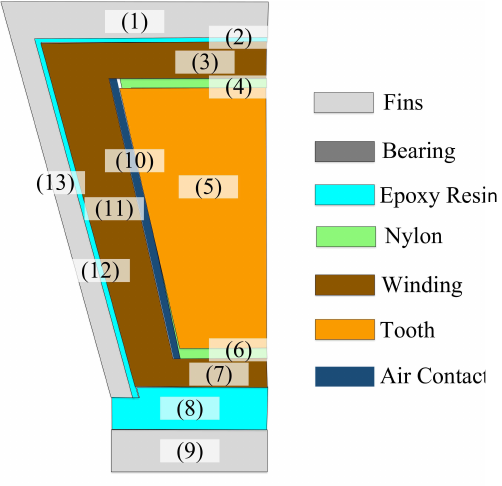
Figure 17. A quarter tooth part illustrating the inward heat extraction fins.